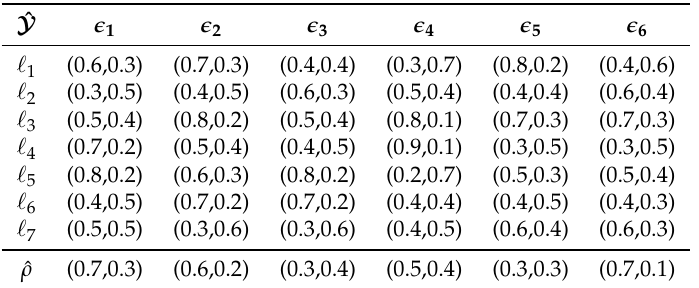
Table 11. The GIFSS ( ˆ F , ˆ A , ˆ ρ )